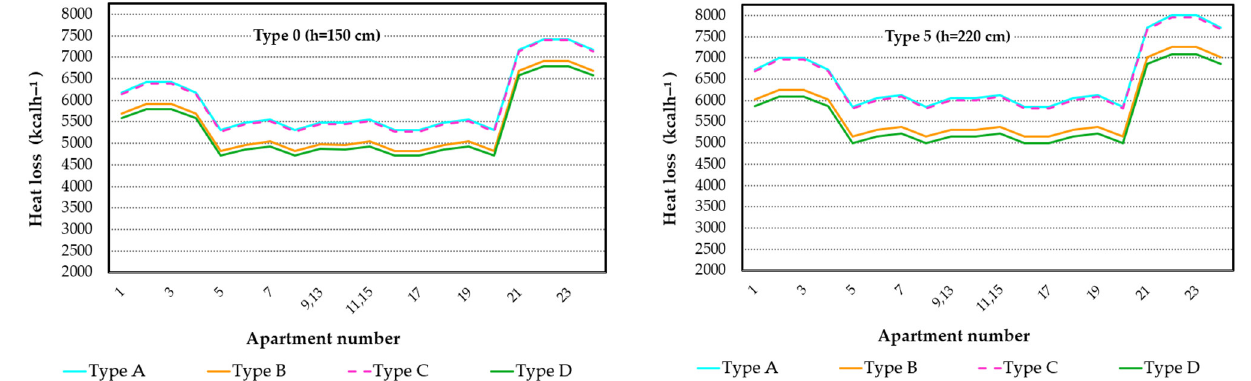
Figure 6. Comparison of window types according to window height (Erzurum).